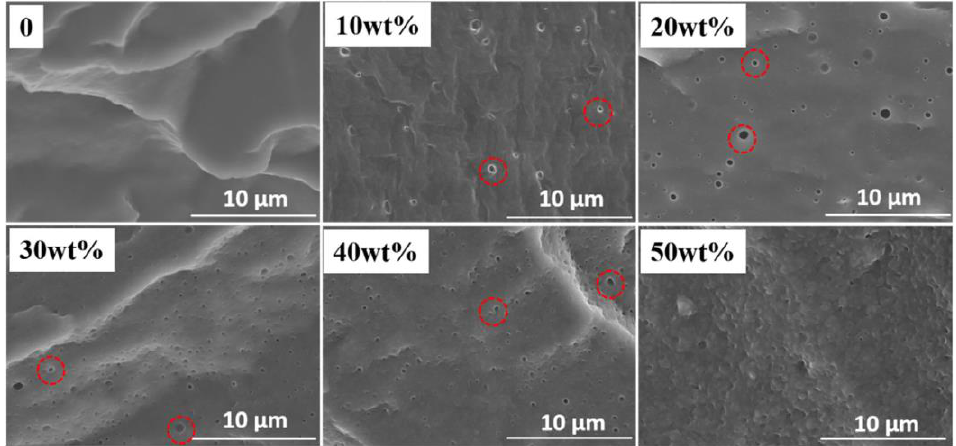
Figure 3. SEM images of the morphology of PDMS- block -PMMA blends at different loadings of PMMA ( wt is weight percent). Red circles highlight supramolecular formations. Reproduced with permission [62]. Copyright 2021, Wiley-VCH.